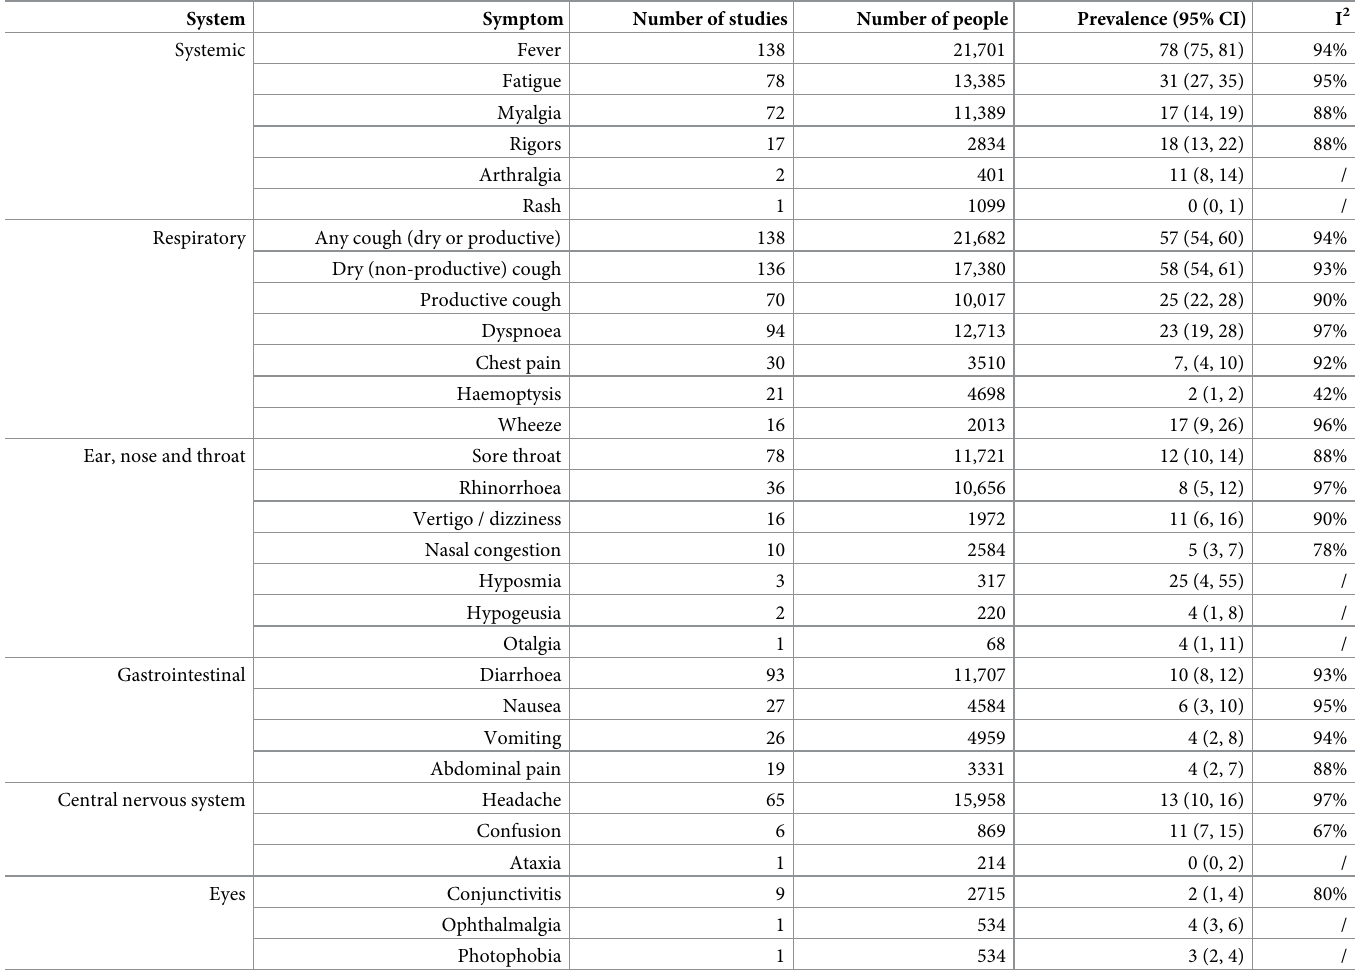
Table 1. Meta-analysis of the prevalence of symptoms in adults with laboratory test confirmed